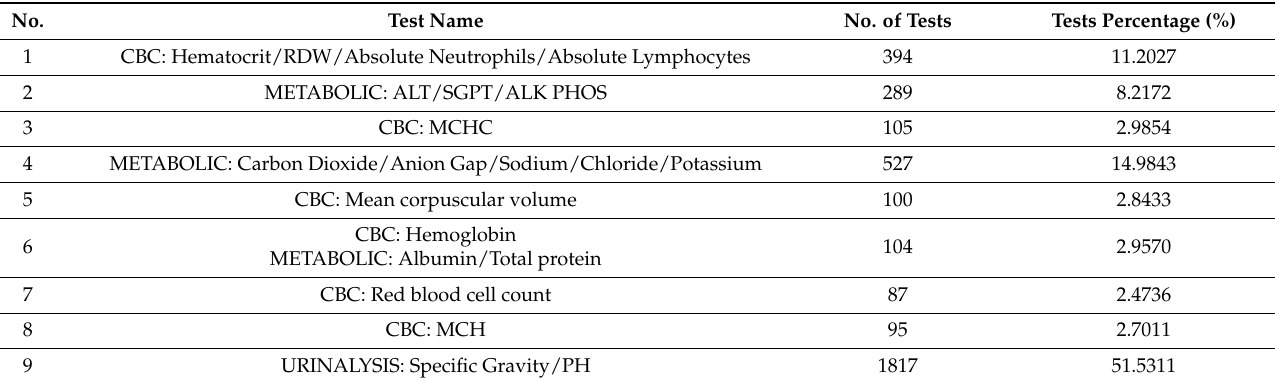
Table 8. Summary of patients’ lab test results.